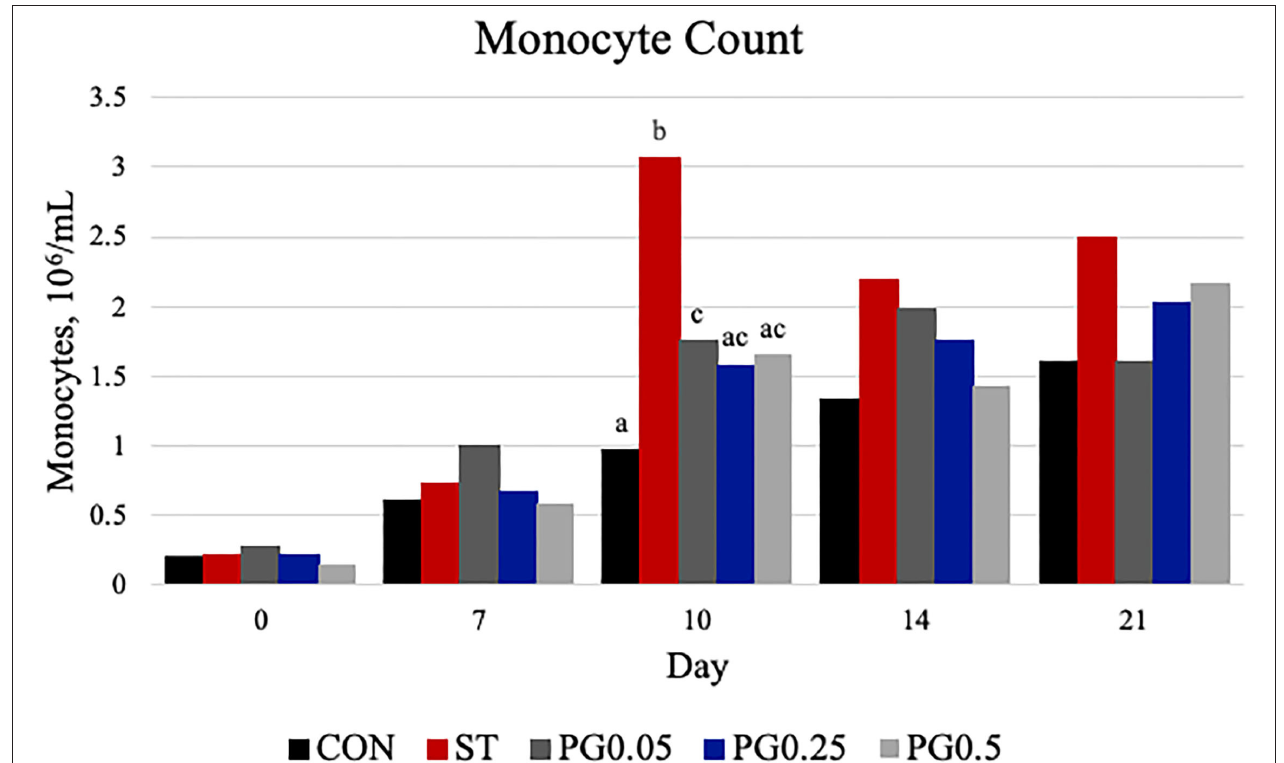
FIGURE 9 | Monocyte count was measured on days 0, 7, 10, 14, and 21. There was a treatment × time interaction ( P = 0.0048). There was a treatment difference on day 10 ( P = 0.0003), where the ST treatment was increased when compared to all other treatments ( P ≤ 0.0038). The largest SEM is reported as 10 6 /ml and include 0.059, 0.2, 0.3925, 0.3714, and 0.5068 for days 0, 7, 10, 14, and 21, respectively. Bars with different superscripts are statistically different ( P < 0.05).